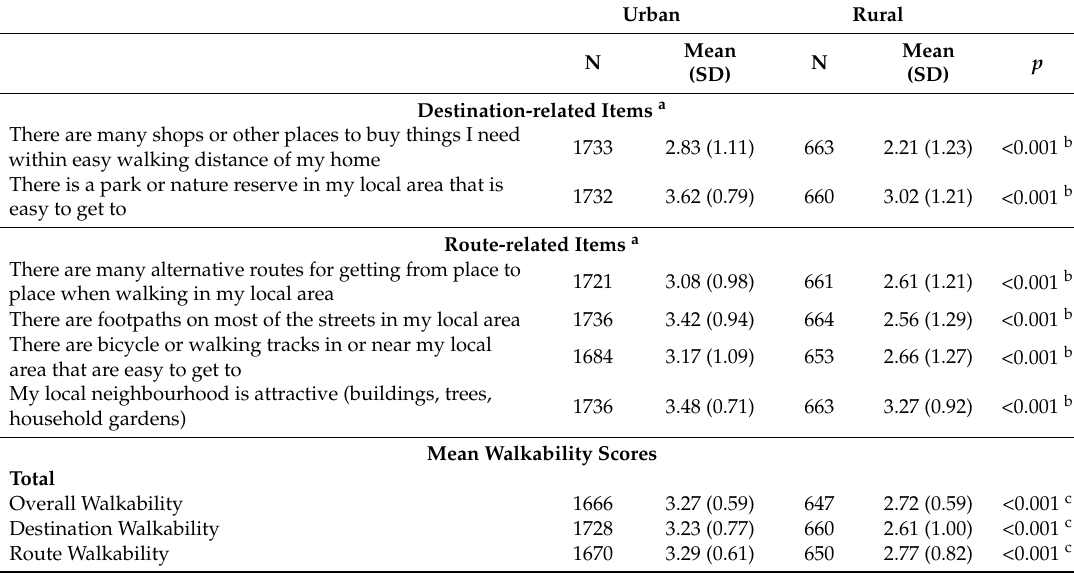
Table 3. Walkability scores by area of